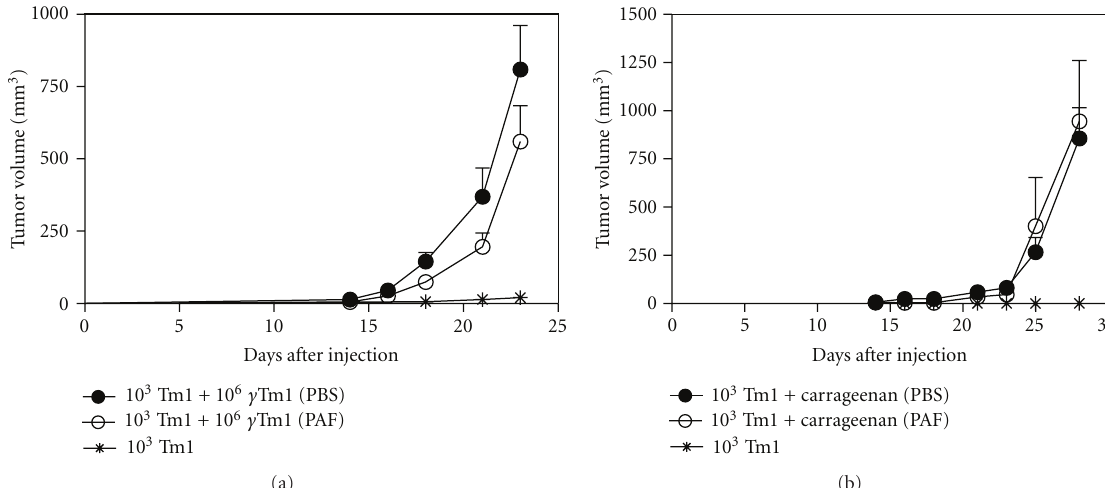
Figure 2: PAF does not a ff ect melanoma progression induced by apoptotic cells or carrageenan. Melanoma growth (10 3 viable Tm1 cells) induced by apoptotic cells (10 6 γ -irradiated Tm1 cells, (a)) or carrageenan (0.1%, (b)) in C57Bl/6 mice did not show any statistical di ff erence between the treatment with PBS or PAF (10 μ g) given by peritumor injection daily for 5 consecutive days.